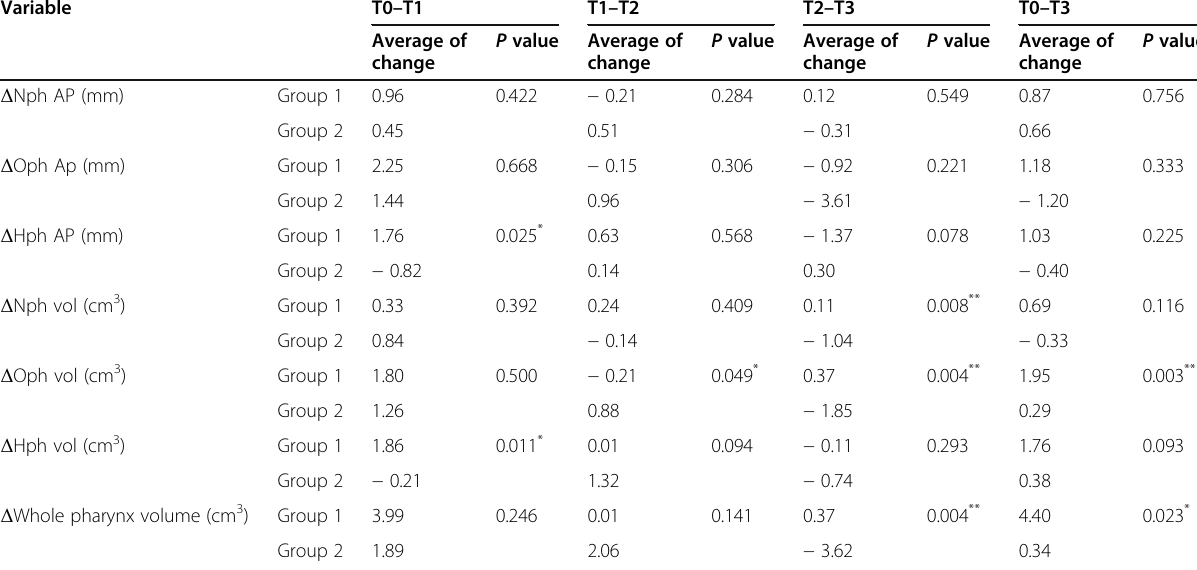
Table 6 Comparison of the amount of changes between group 1 (BSSRO) and group 2 (BSSRO + Le Fort I osteotomy) Variable T0 – T1 T1 – T2